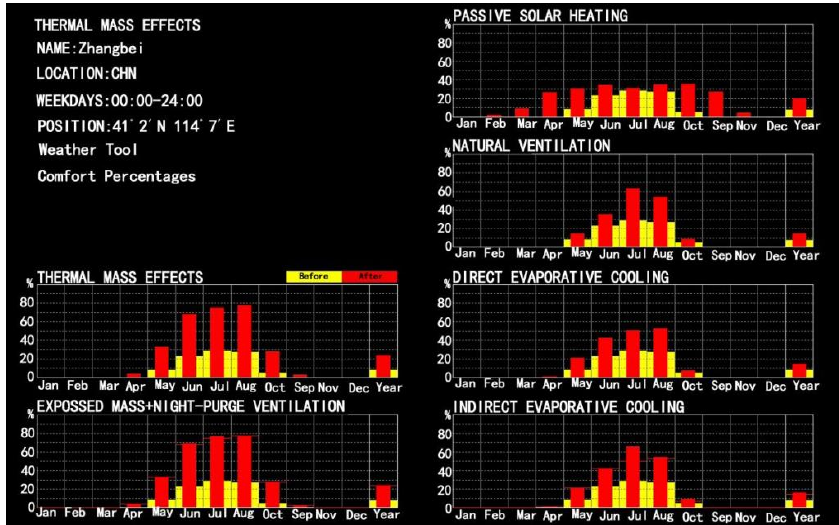
Figure 7. Combination analysis of passive strategies.